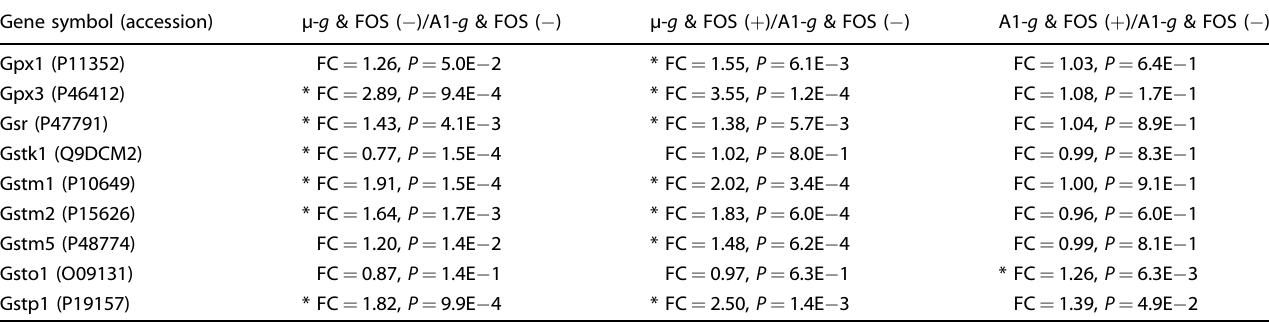
The protein abundance pro fi les of the groups exposed to µ- g with and without FOS ingestion and the group exposed to A1- g with FOS ingestion were individually compared with that of the group exposed to A1- g without FOS ingestion. The results for the proteins, which were categorized as the related factors to glutathione metabolic process, glutathione-mediated detoxi fi cation and/or glutathione redox reactions by DAVID Bioinformatics Resources 6.8 and Ingenuity Pathway Analysis and signi fi cantly ( p <0.01) affected by µ- g exposure and/or FOS ingestion, in Sol muscles are indicated. The fold change (FC) and p value ( P ) of each protein are depicted. *: the signi fi cant high- or low-abundance proteins.